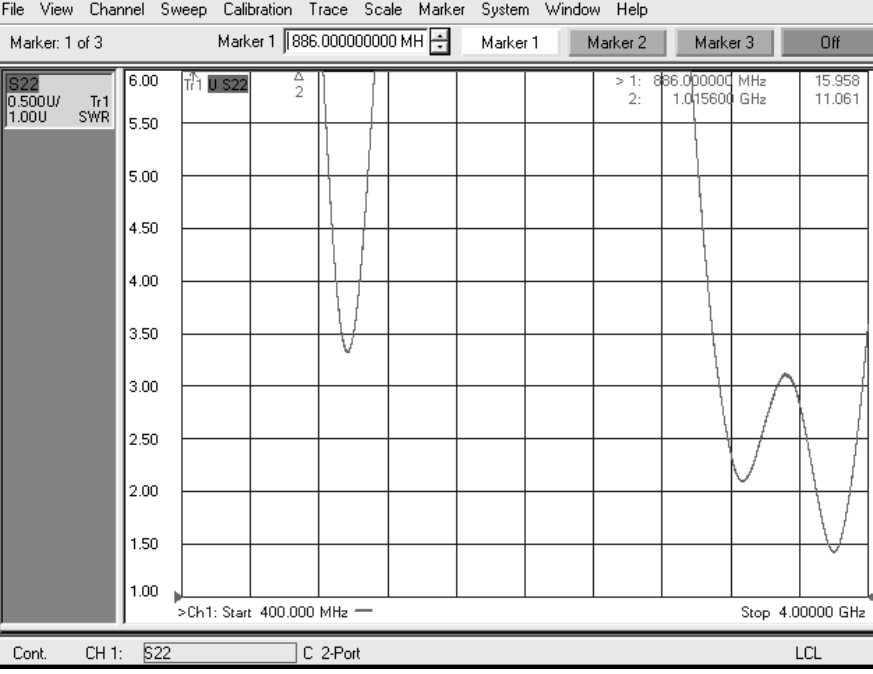
Fig. 4. S22 parameter for 8 cascade